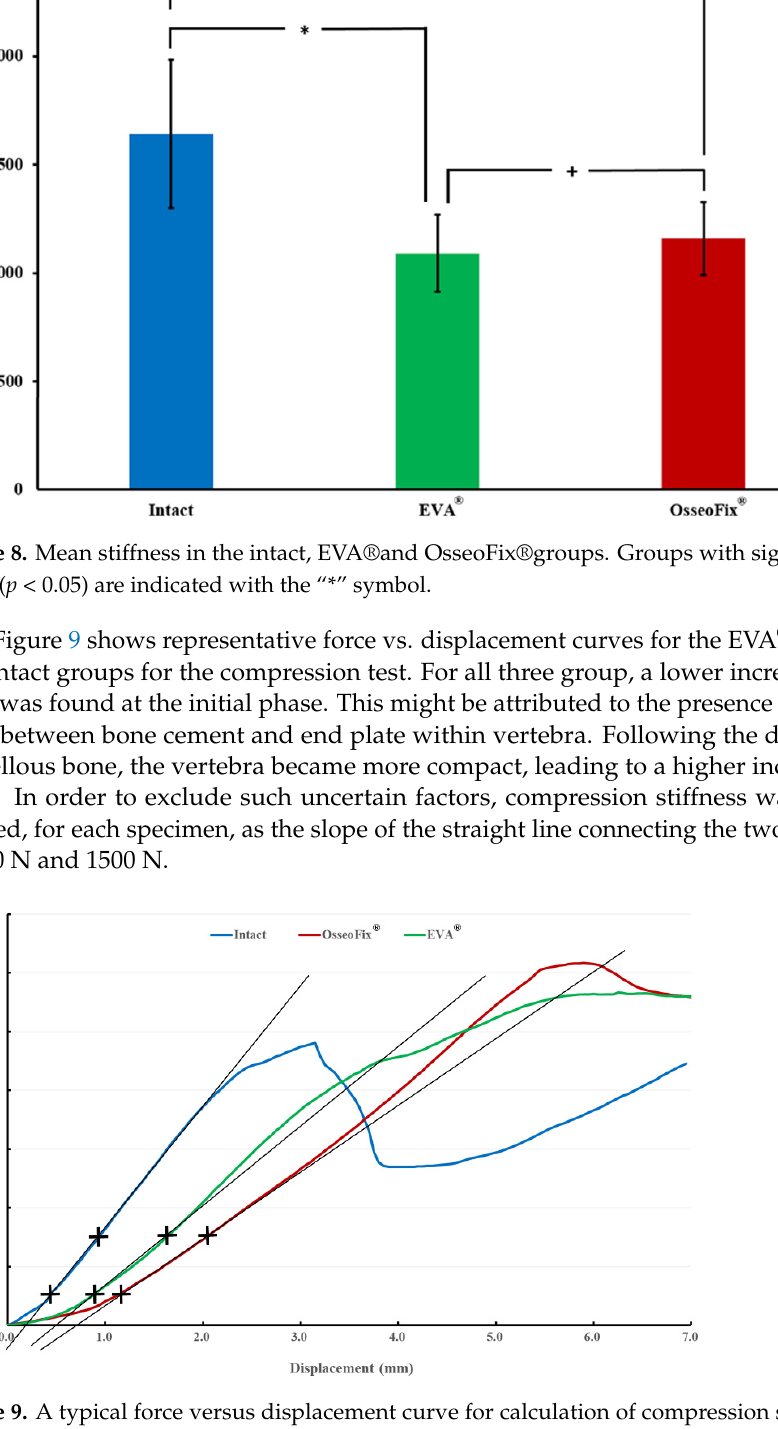
Figure 7. Mean ultimate strength in the intact, EVA® and OsseoFix® groups. Groups with signifi- cant differences ( p < 0.05) are indicated with the “*” symbol.